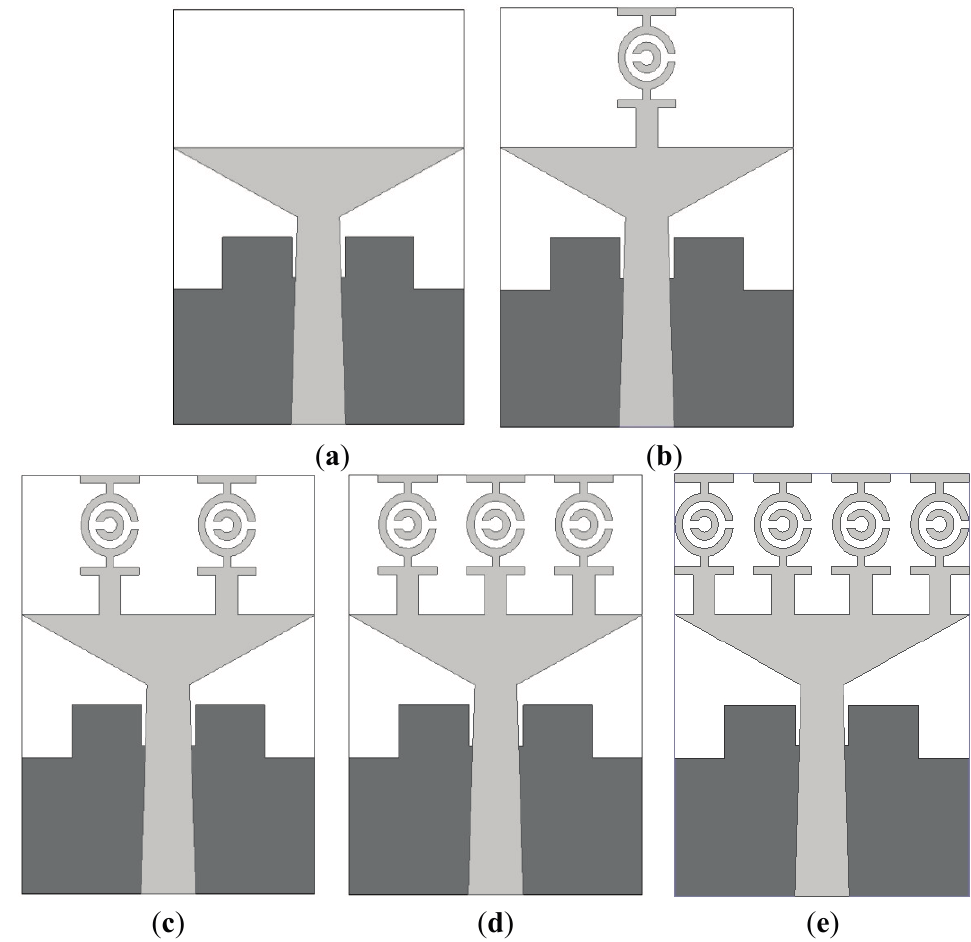
Figure 9. The proposed antenna. ( a ) No unit cell; ( b ) One unit cell; ( c ) Two unit cells; ( d ) Three unit cells; ( e ) Four unit cells (proposed).